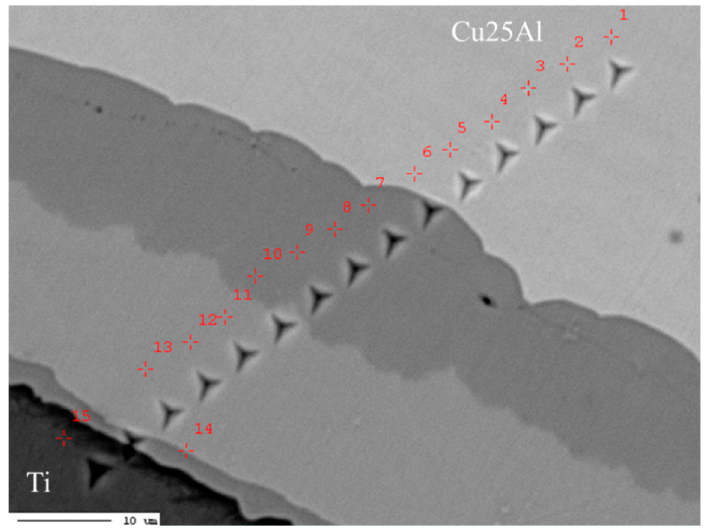
Figure 6. The nanoindentations of the Cu25Al–Ti interface diffusion zone, 650 °C × 400 h.